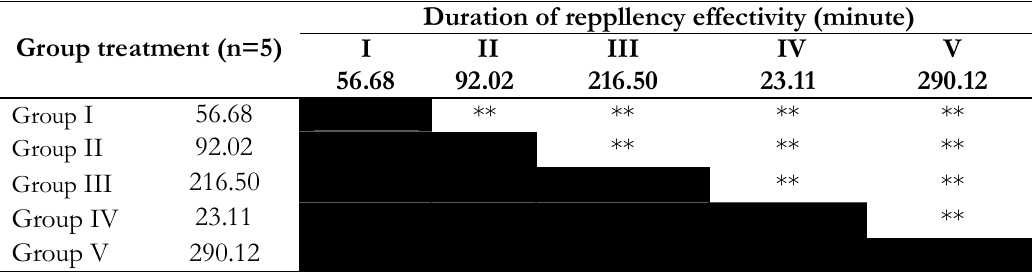
Figure 1. Study design by Fradin and Day method (Fradin and Day, 2002) Table I. Result of Tukey HSD test of mean duration time of reppllency effectivity of citronella oil lotion to Culex sp.